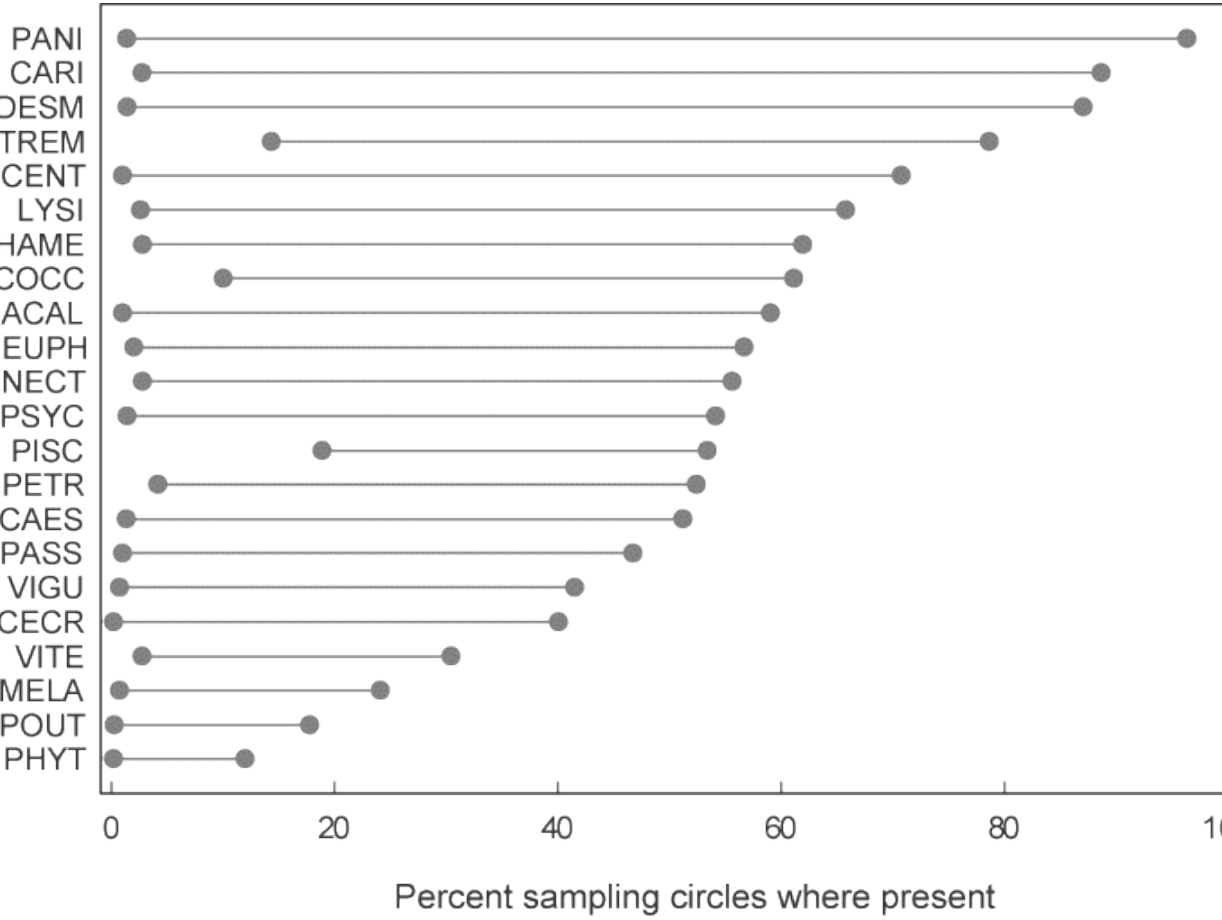
Fig. 5. Range in relative frequency of 17 forage and five firewood species. Circles indicate the minimum and maximum relative frequencies observed for each species. Note that sites where species were absent were excluded. Species' codes as in Tables 1 and